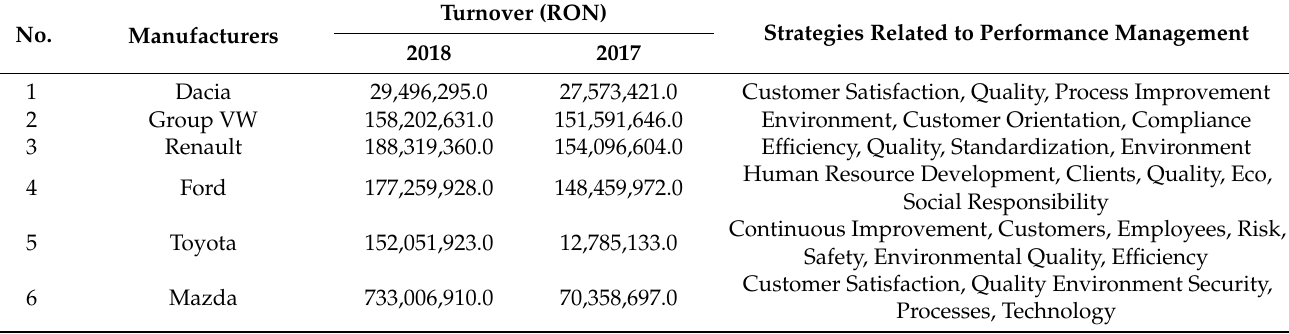
Table 6. Romanian market companies operating in the field of car services.